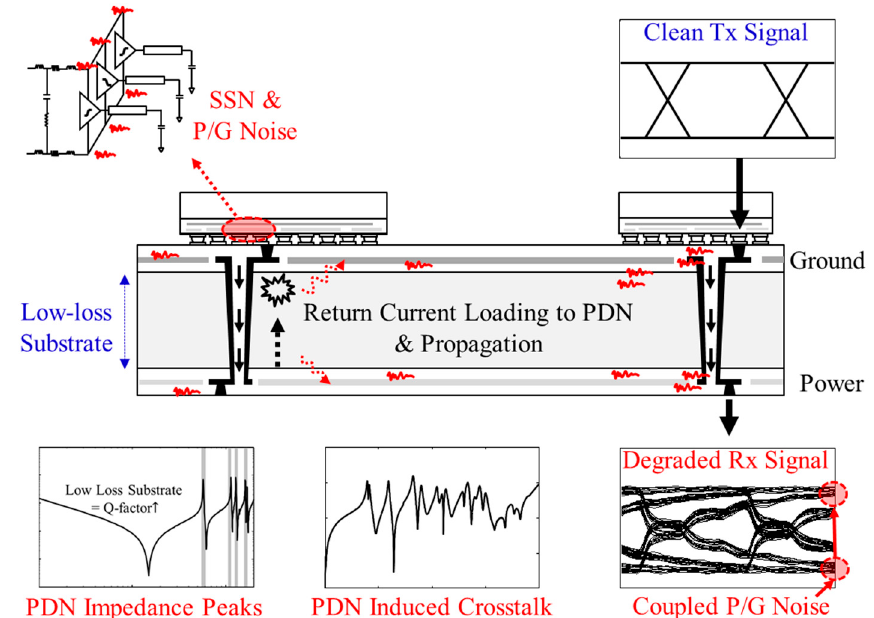
Figure 2. Issues related to low-loss substrate. When the noise is induced in the PDN due to SSN, P/G noise, or return current loading, low substrate loss cannot suppress it. The noise propagates along the PDN and causes SI/PI problems.